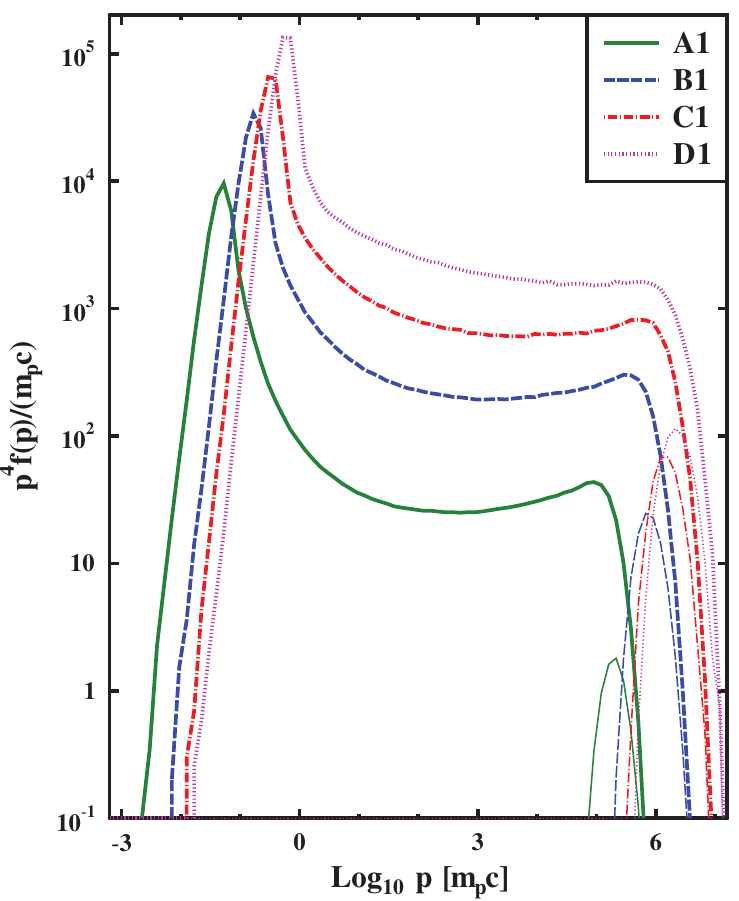
Figure 7. Particle distribution function in the shock rest frame, thick curves correspond to the point x = 0 (the front shock), thin curves correspond to a point x = x FEB . The correspondence of the certain model Table 1 is reflected in the